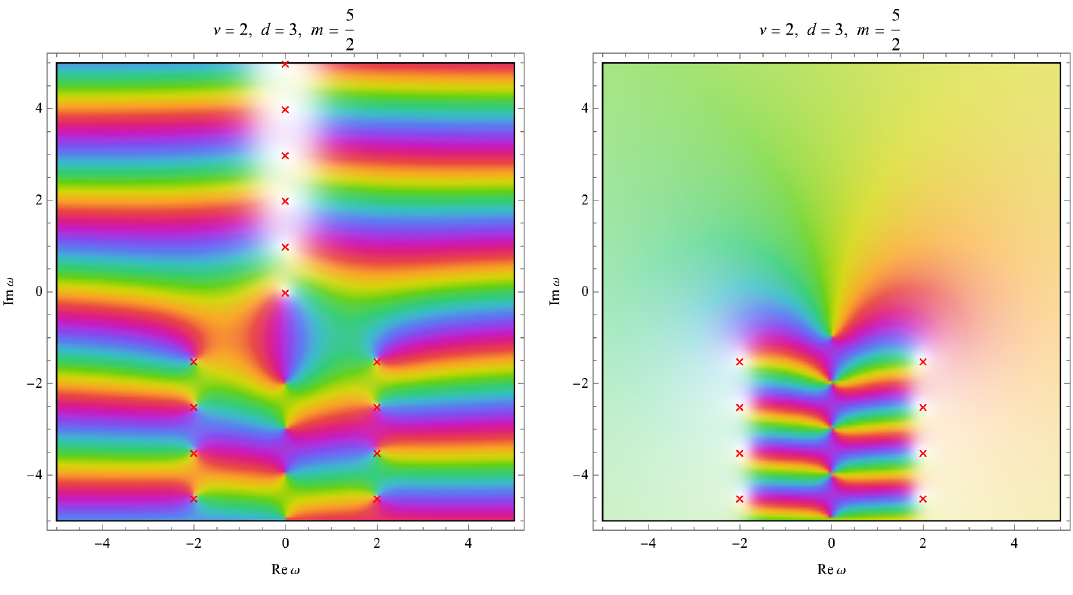
h i ˆ C ( ω, θ ) vs ω . Left θ = 0 and right θ = π . The red crosses